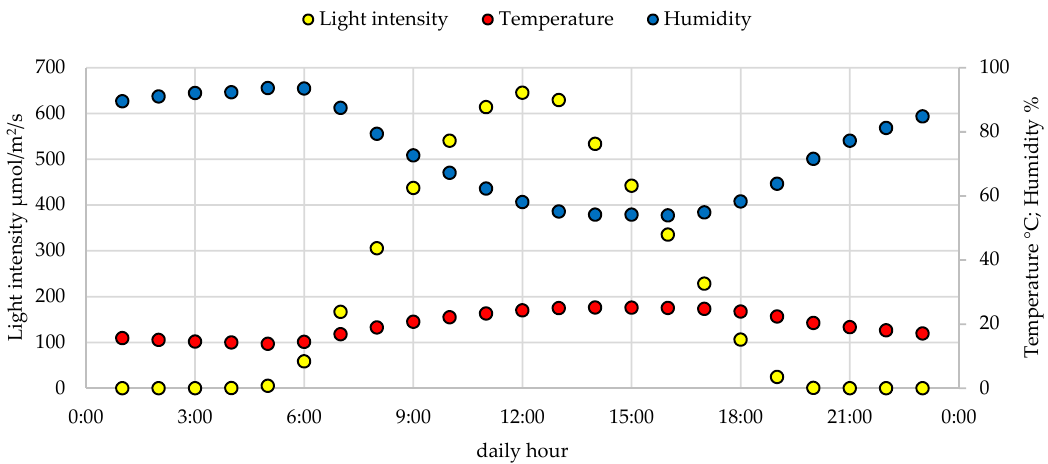
Figure 1. Settings of daily weather conditions of the pot experiment. Table 1. Chemical composition of soil used in this study.